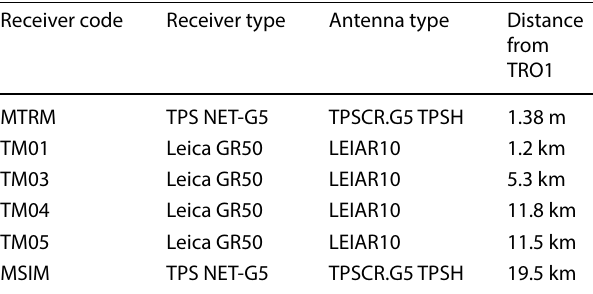
Fig. 1 Geographic locations of the GNSS receivers. Red stars are RTK network receivers, while blue triangles are monitor receivers Table 1 Information about monitor receivers used and their dis- tance from the closest network RTK